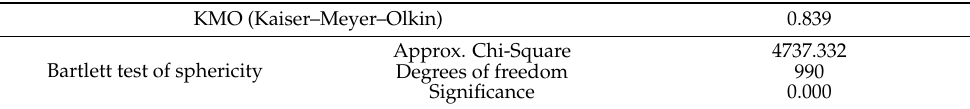
Table 3. KMO and Bartlett’s